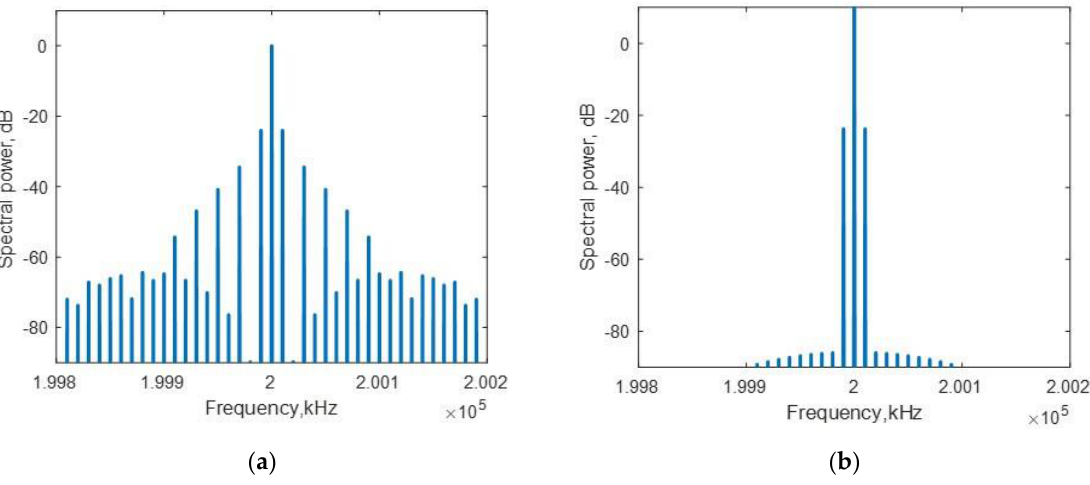
Figure 15. Examples of the spectra calculated from the bilinear crack models: ( a ) probe wave 0 dB and pump wave 10 dB; ( b ) probe wave 10 dB and pump wave 0 dB.